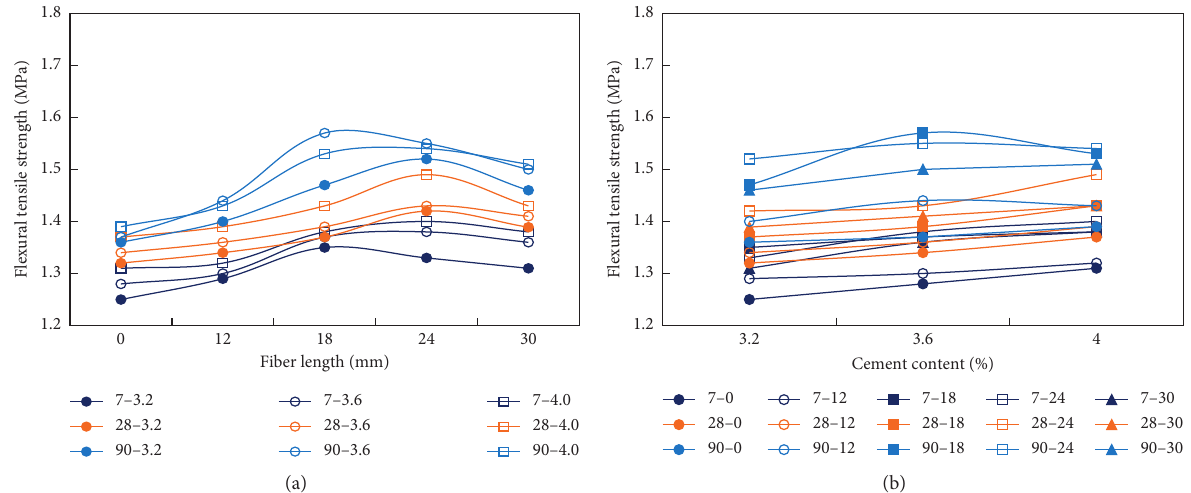
Figure 16: Trend chart of FTS of CSM: (a) fiber length and (b) cement